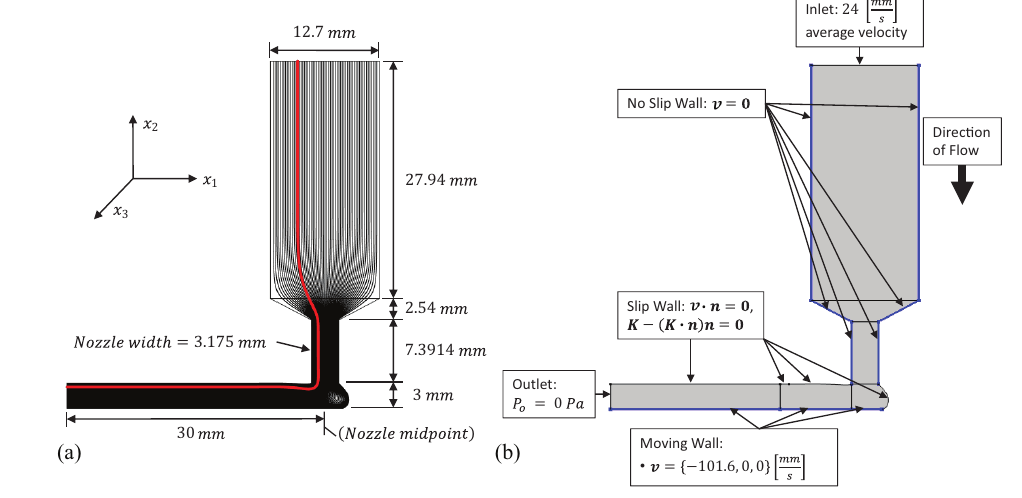
Figure 1. ( a ) The flow domain and dimensions; streamline 15 is highlighted in red. ( b ) The flow domain with boundary conditions.